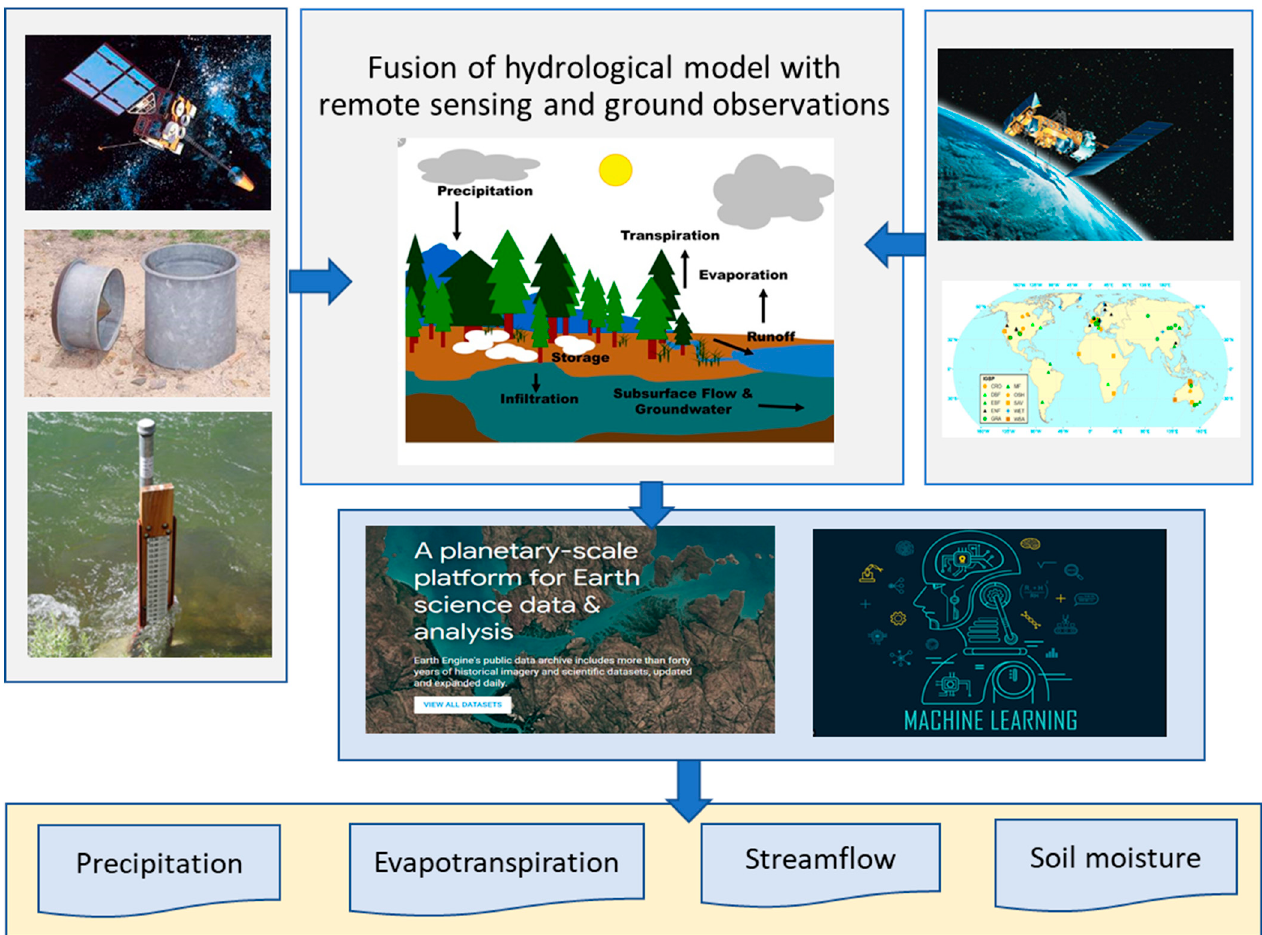
Figure 1. Conceptualized summary of model and data fusion techniques for improving hydrological predictions.